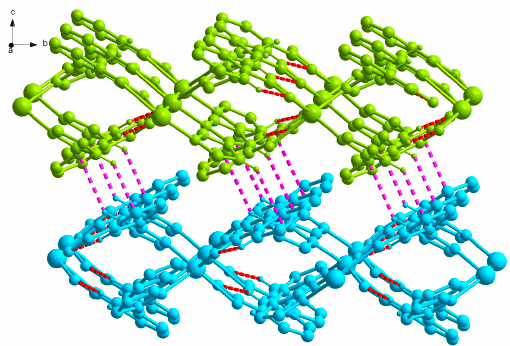
Figure 4. 3D supramolecular network structure of 1 linked by C-H··· π stacking interactions.